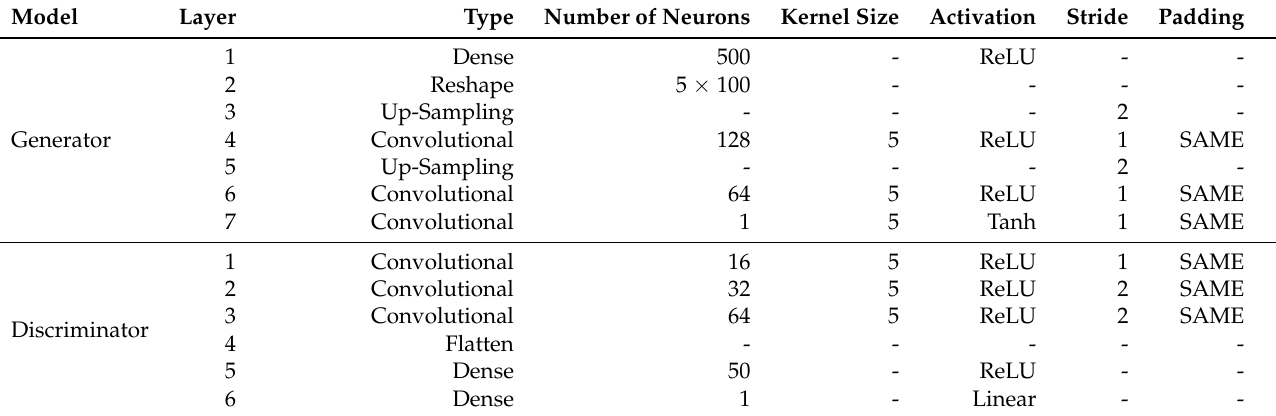
Table 3. Generative model